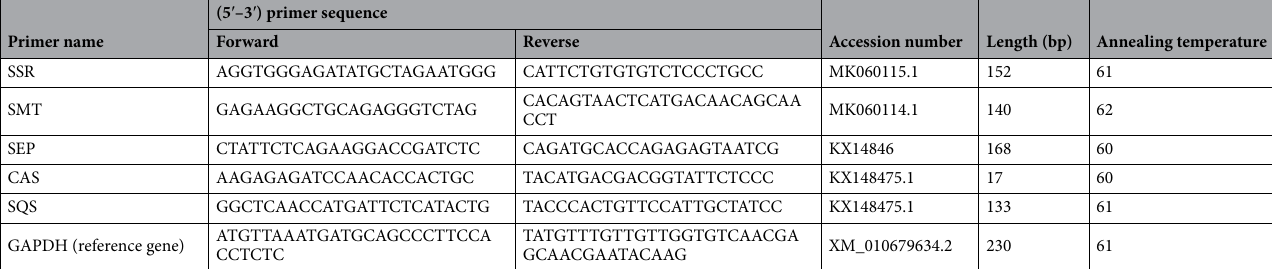
Table 1. Primers used in this study and their